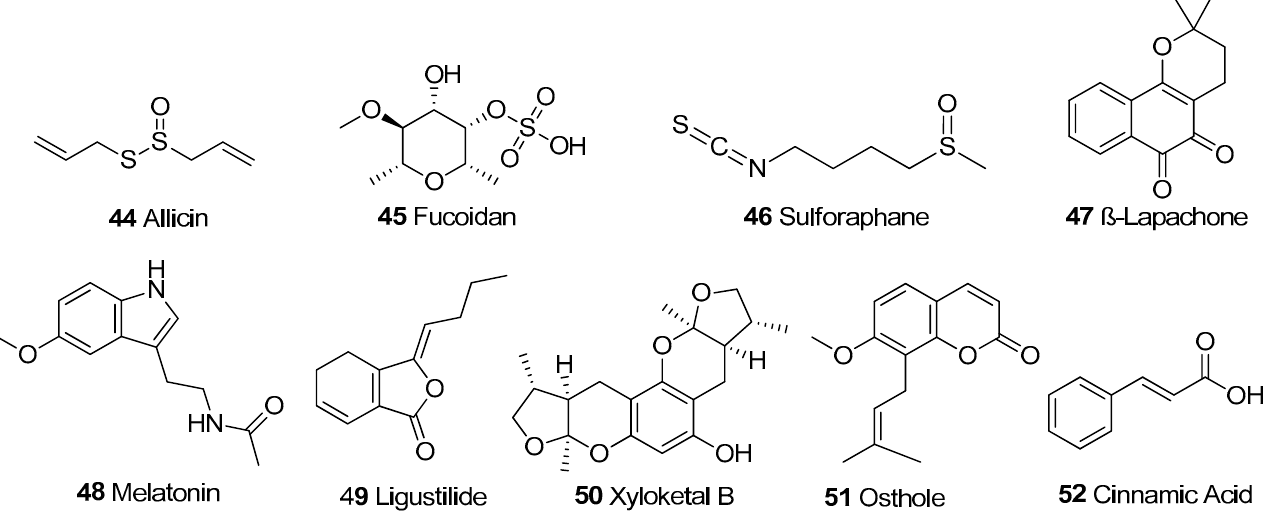
Figure 6. Chemical structures of terpenes.